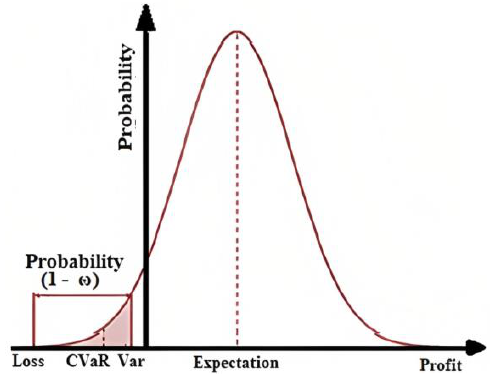
Figure 1. CVaR and VaR representation.